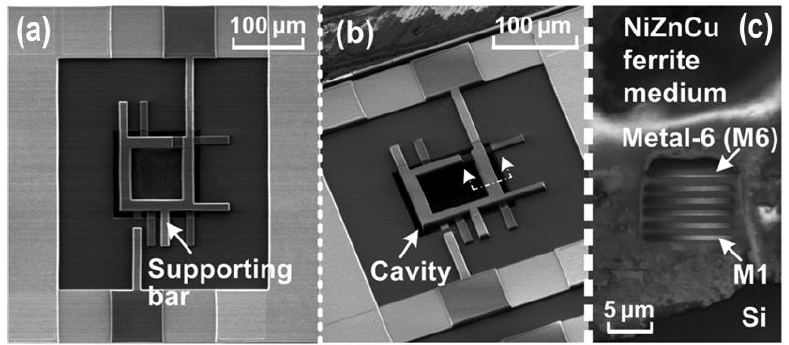
Figure 5. SEM photos for a vertical nanomagnetic particle-filled 6-Al-layer stacked spiral inductor fabricated in a 180 nm CMOS: ( a ) top view, ( b ) tilt view, and ( c ) cross-section view [20].